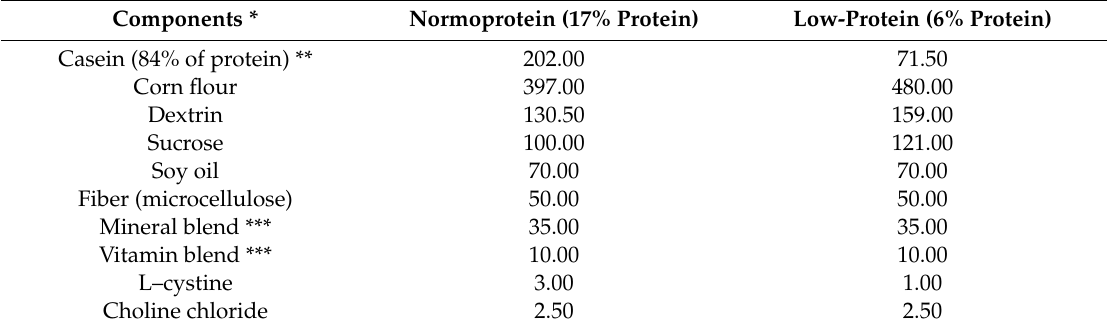
Table 1. Composition of the food provided to the animals during the gestation and lactation periods. Components